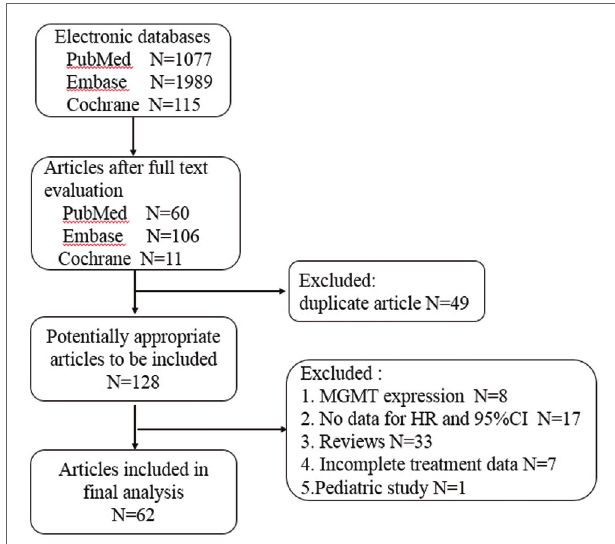
FiGURe 1 | Flow diagram of study